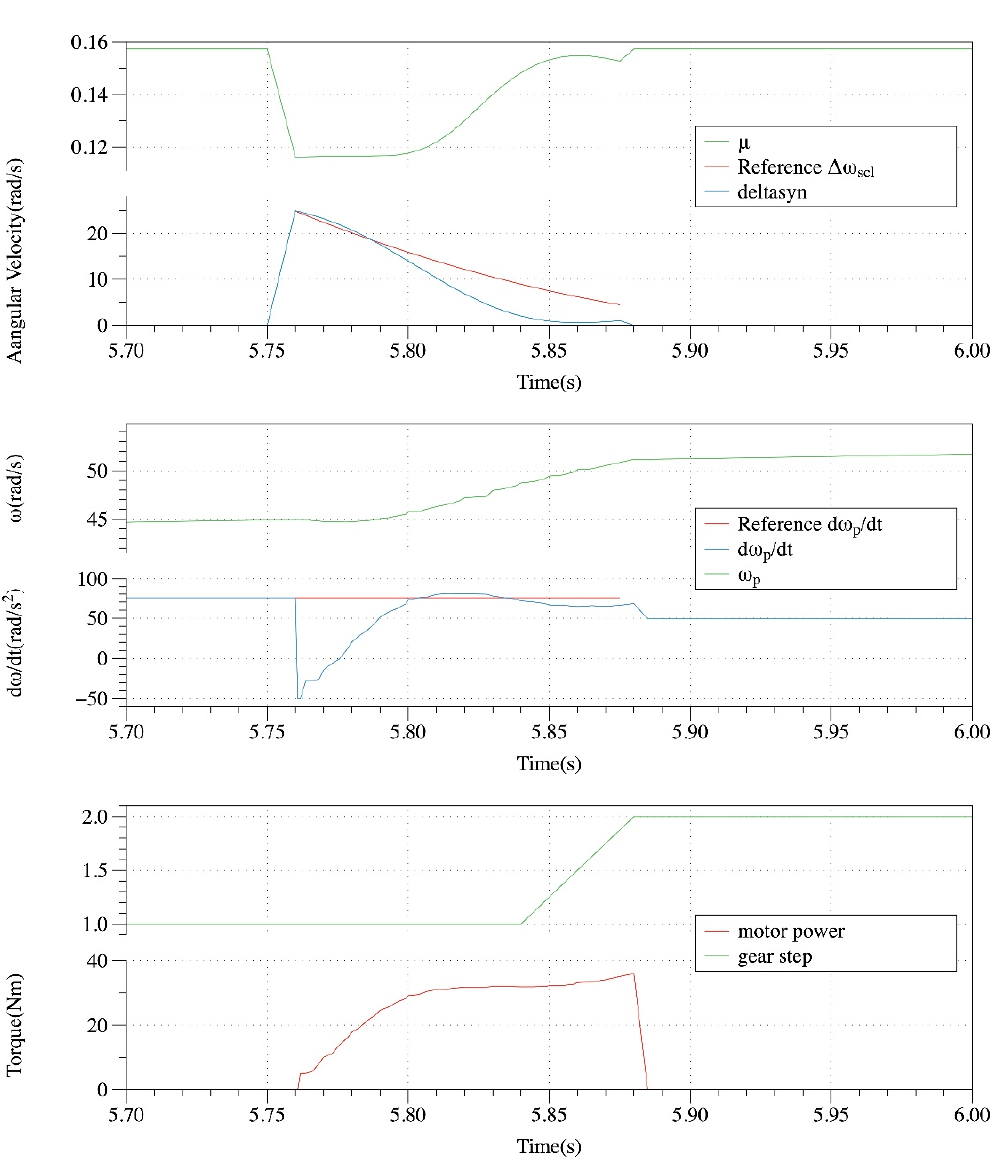
Figure 17. The shifting performance with θ = 8 ◦ and change of µ well estimated.